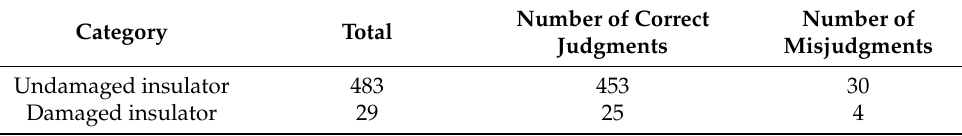
Table 5. Damage detection results based on Hu moment.